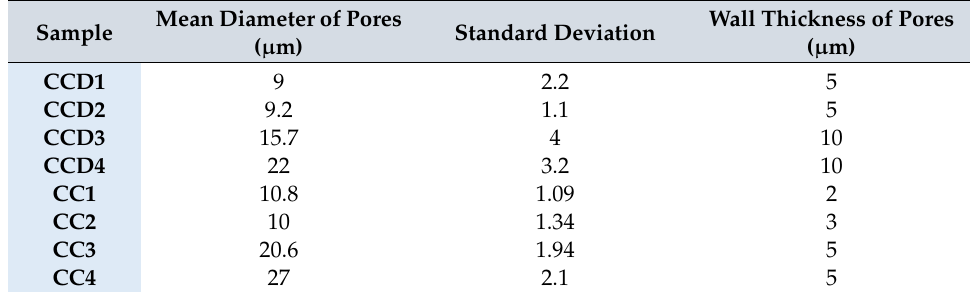
Table 2. Morphological parameters for the drug delivery systems and reference